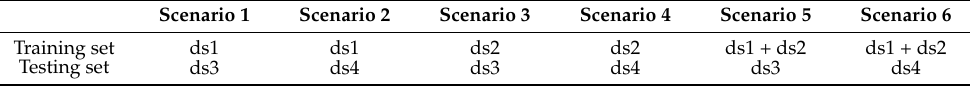
Table 3. Training set vs. Testing